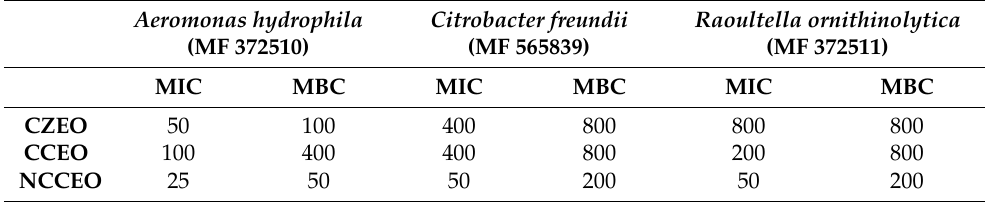
Table 3. Minimum inhibitory concentration (MIC) and minimum bactericidal concentration (MBC) of Cinnamomum zeylanicum EO (CZEO), Cinnamomum cassia EO (CCEO), and its nanoemulsion (NCCEO) against three clinical isolates of fish pathogenic bacteria. The values are expressed in µ g/mL. Aeromonas hydrophila Citrobacter freundii (MF 372510) (MF 565839)